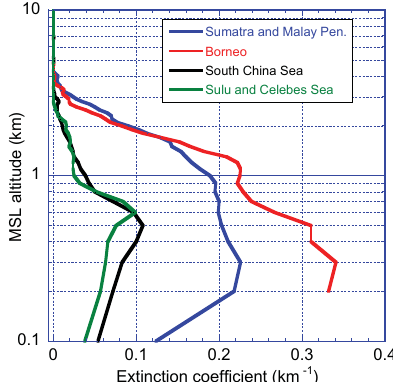
Figure 4. August–October mean CALIOP extinction coefficients for 5 × 5 ◦ boxes over southern/central Sumatra and the Malay Peninsula; south-central Borneo, the southern South China Sea, and the Sulu and Celebes